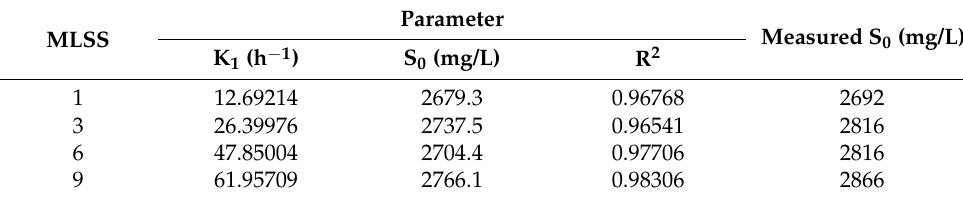
Figure 5. Changes in COD with different initial pH values using linear fitting. Table 3. The kinetic parameters under different MLSS.